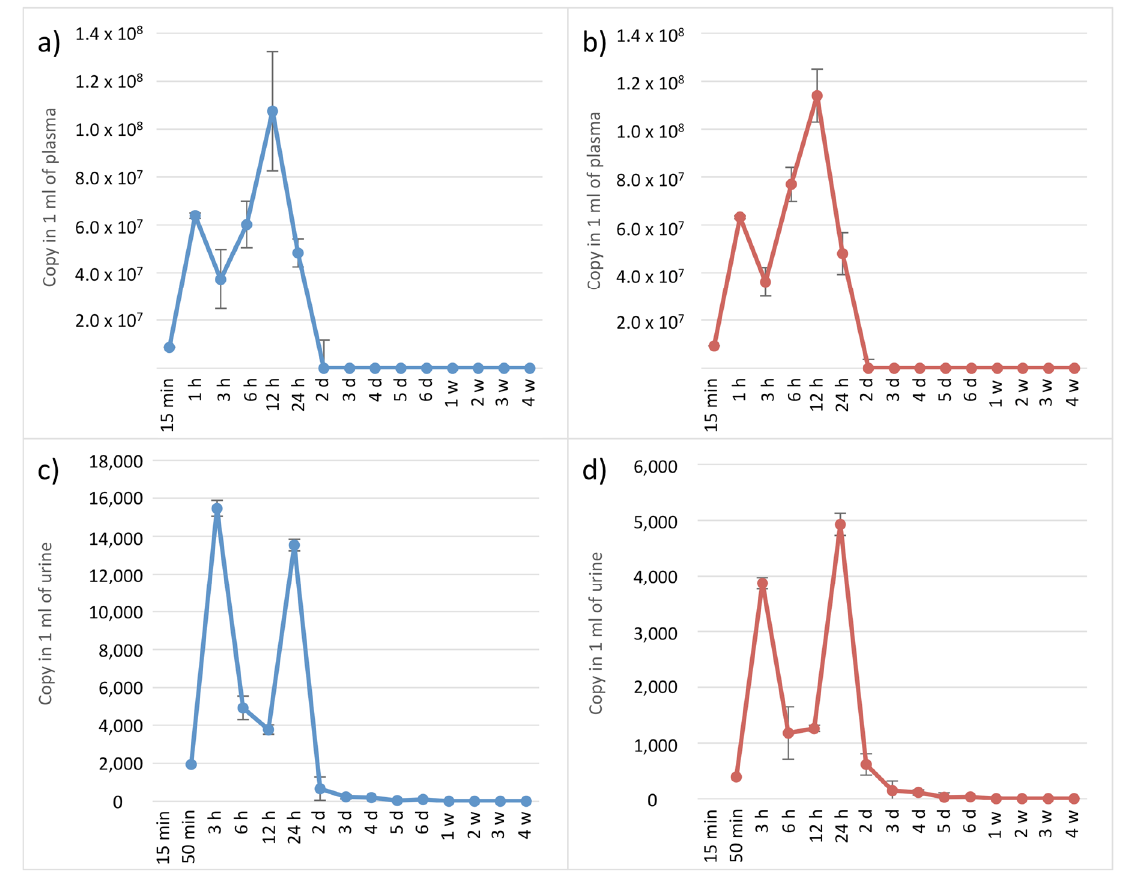
Figure 5. Copy number of the EPO transgene detected in 1 mL of plasma and urine, respectively, following plasmid administration to a horse. ( a ) Copy number amplified by SET1 using extracts from plasma, ( b ) copy number amplified by SET2 using extracts from plasma, ( c ) copy number amplified by SET1 using extracts from urine, ( d ) copy number amplified by SET2 using extracts from urine.